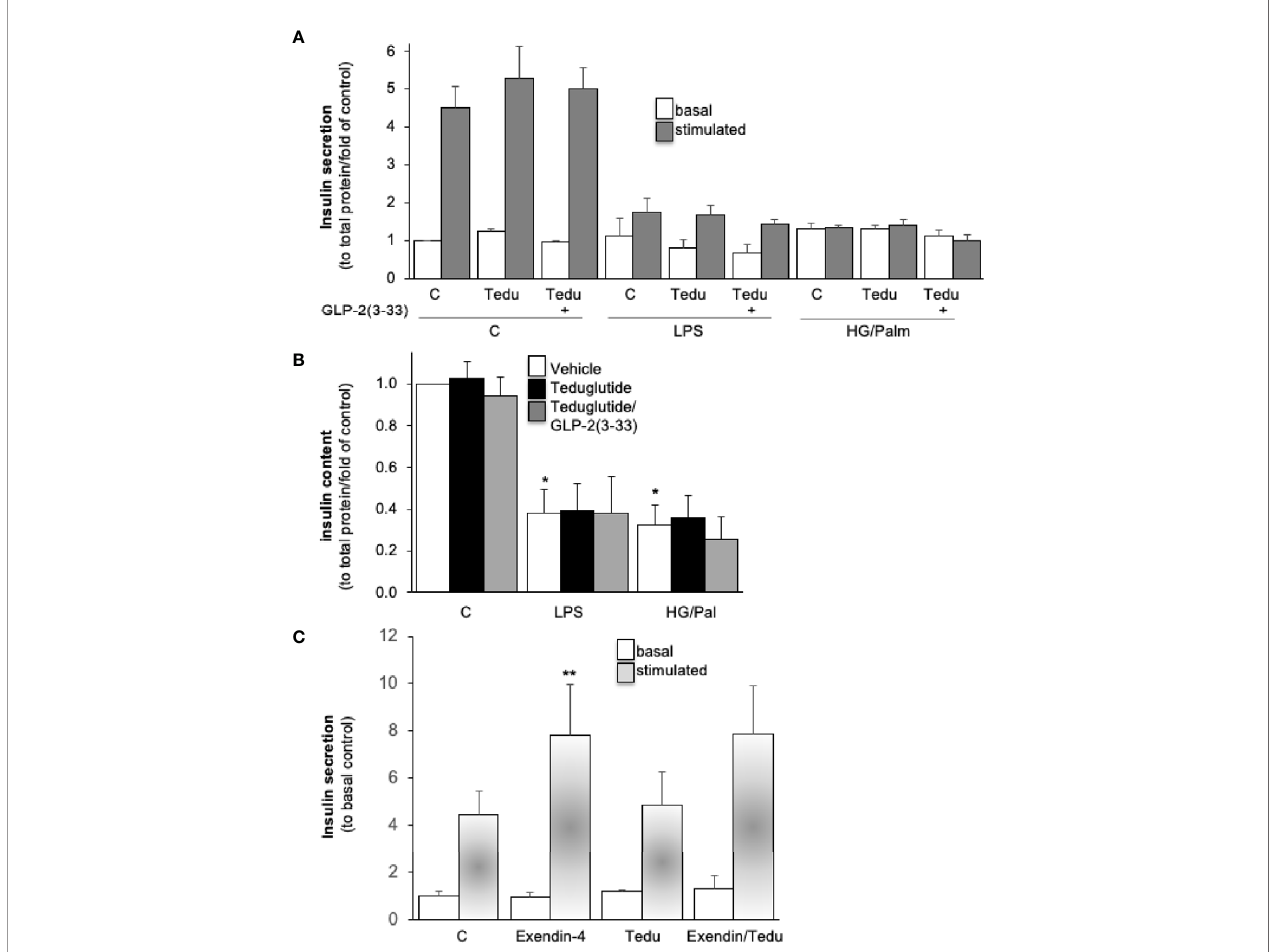
FIGURE 3 | Intra-islet GLR-2R activation with no impact on b -cell function. Isolated human islets were cultured on ECM-coated dishes and pretreated with 10 nM teduglutide or plus 5 nM GLP-2(3-33) for 2 hours, then LPS or a combined HG/Pal was added into the culture medium and maintained for 72h. Afterwards, cultured islets were analyzed for (A) glucose-stimulated insulin secretion (2.8mM glucose (basal) for 1 hour, followed by 16.7mM glucose (stimulated) for 1 hour, and (B) intracellular insulin content and presented as secreted insulin to total protein content and normalized to the basal control condition (A, B) . Acute effect of teduglutide during glucose stimulation; human islets were incubated after the 72h culture at control with 2.8mM glucose (basal) for 1 hour, followed by 16.7mM glucose (stimulated) for 1 hour with the addition of exendin-4, teduglutide or both (C) . Data are presented as means ± SEM from 3 (A, B) or one (C) different human islet isolations. *p < 0.05 LPS/glucose vs . vehicle control, **p < 0.05 exendin-4 vs . respective control, both under glucose stimulated conditions by paired two-tailed